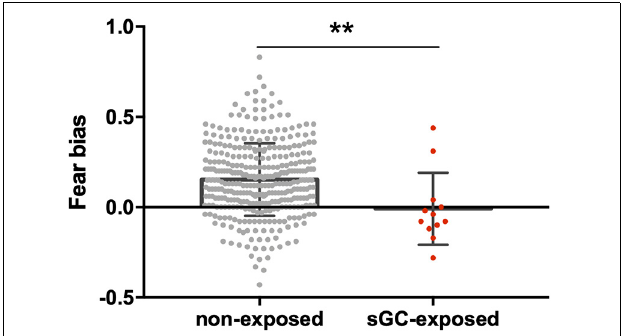
FIGURE 2 | Comparison between 8-month-old infants with prenatal sGC treatment exposure (sGC-exposed) and without treatment exposure (non-exposed). The sGC group showed a statistically significant reduction in fear bias. ** p <